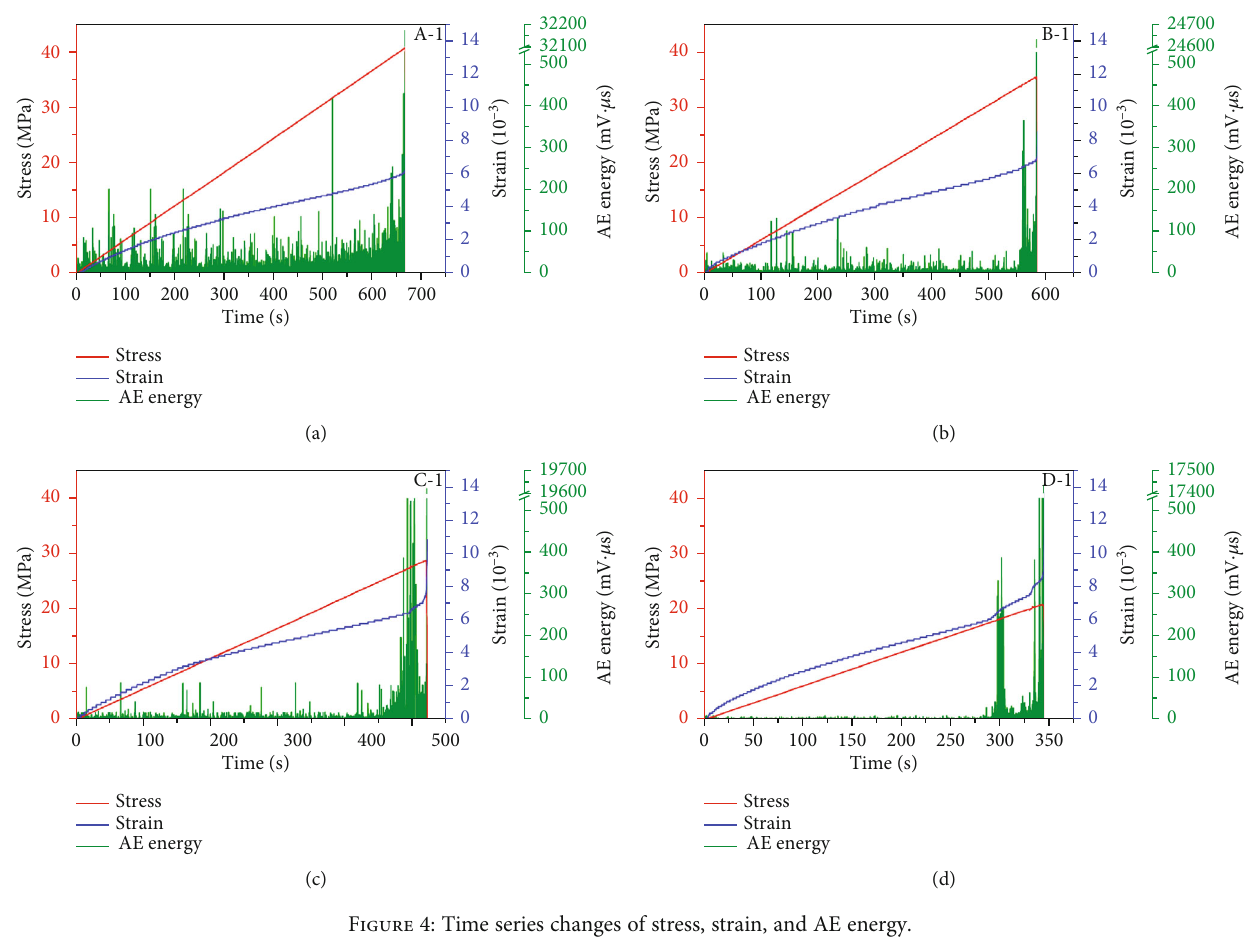
Figure 4: Time series changes of stress, strain, and AE energy.